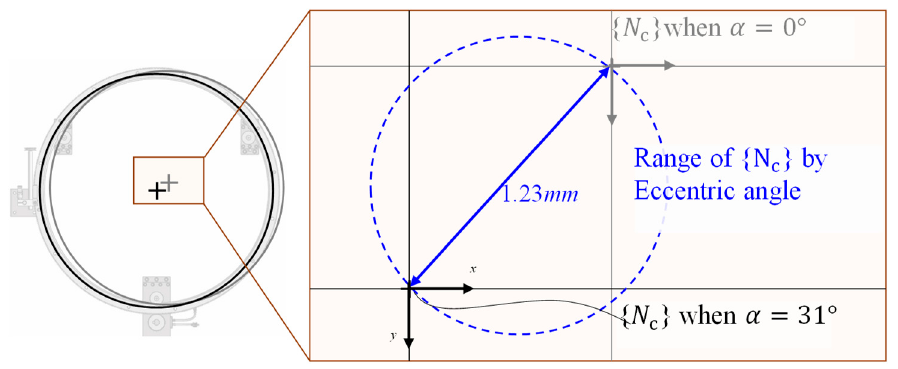
Figure 16. Schematic of the reference square and eccentric bearing.